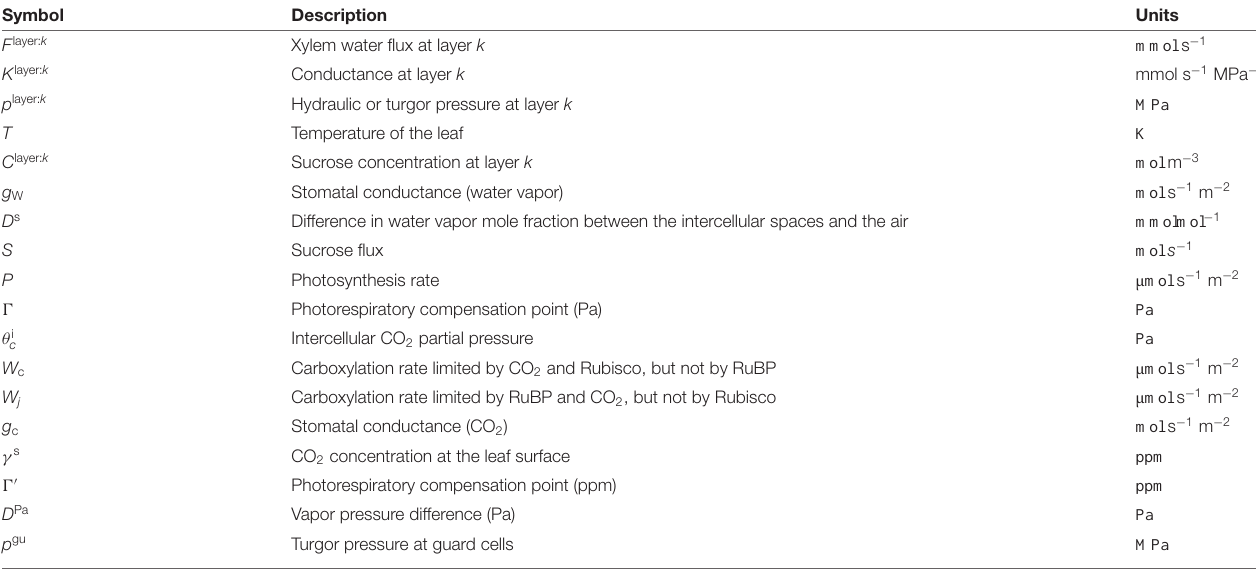
TABLE 2 | Summary of function variables, at node ij (subscripts are not